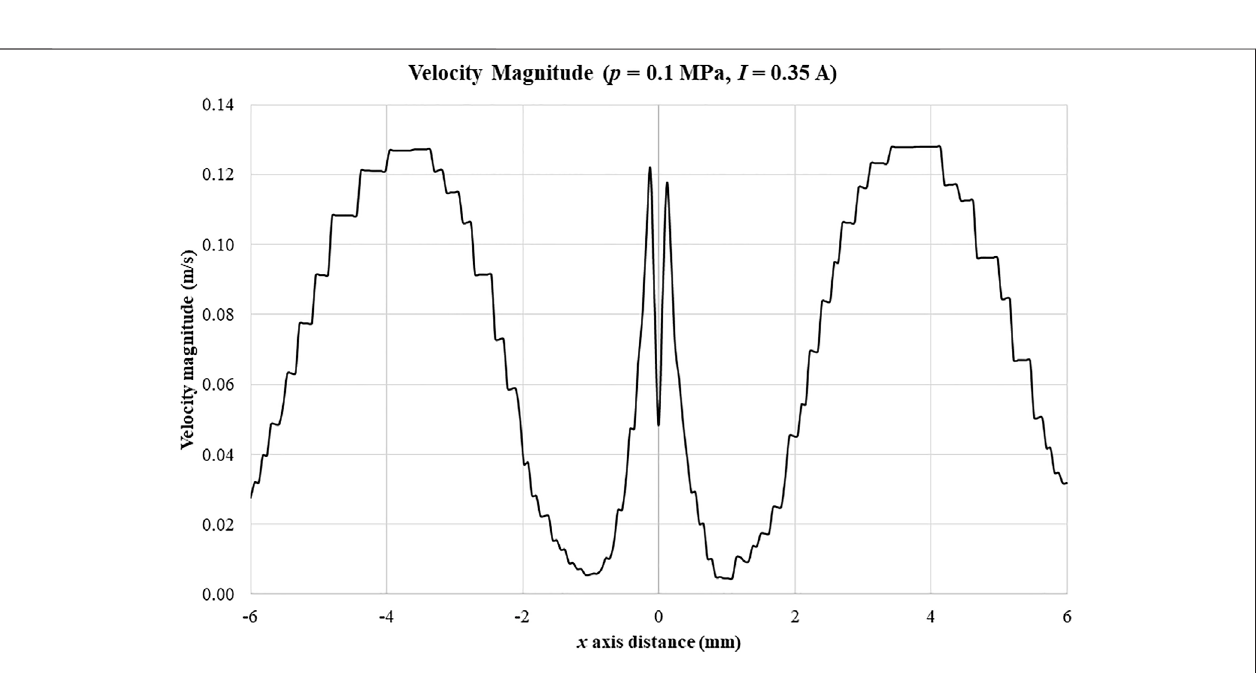
Frontiers in Physics |